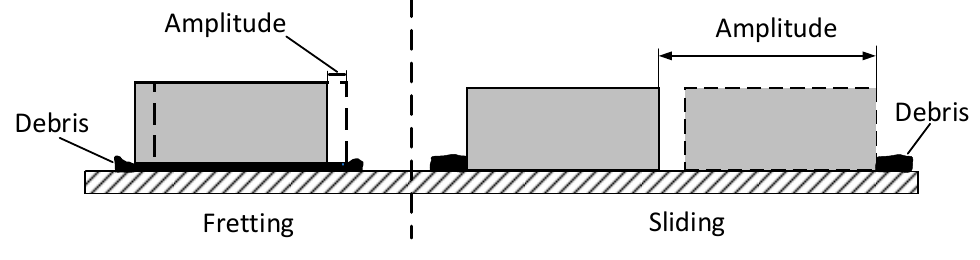
Figure 1. Concept of overlap in fretting and sliding.